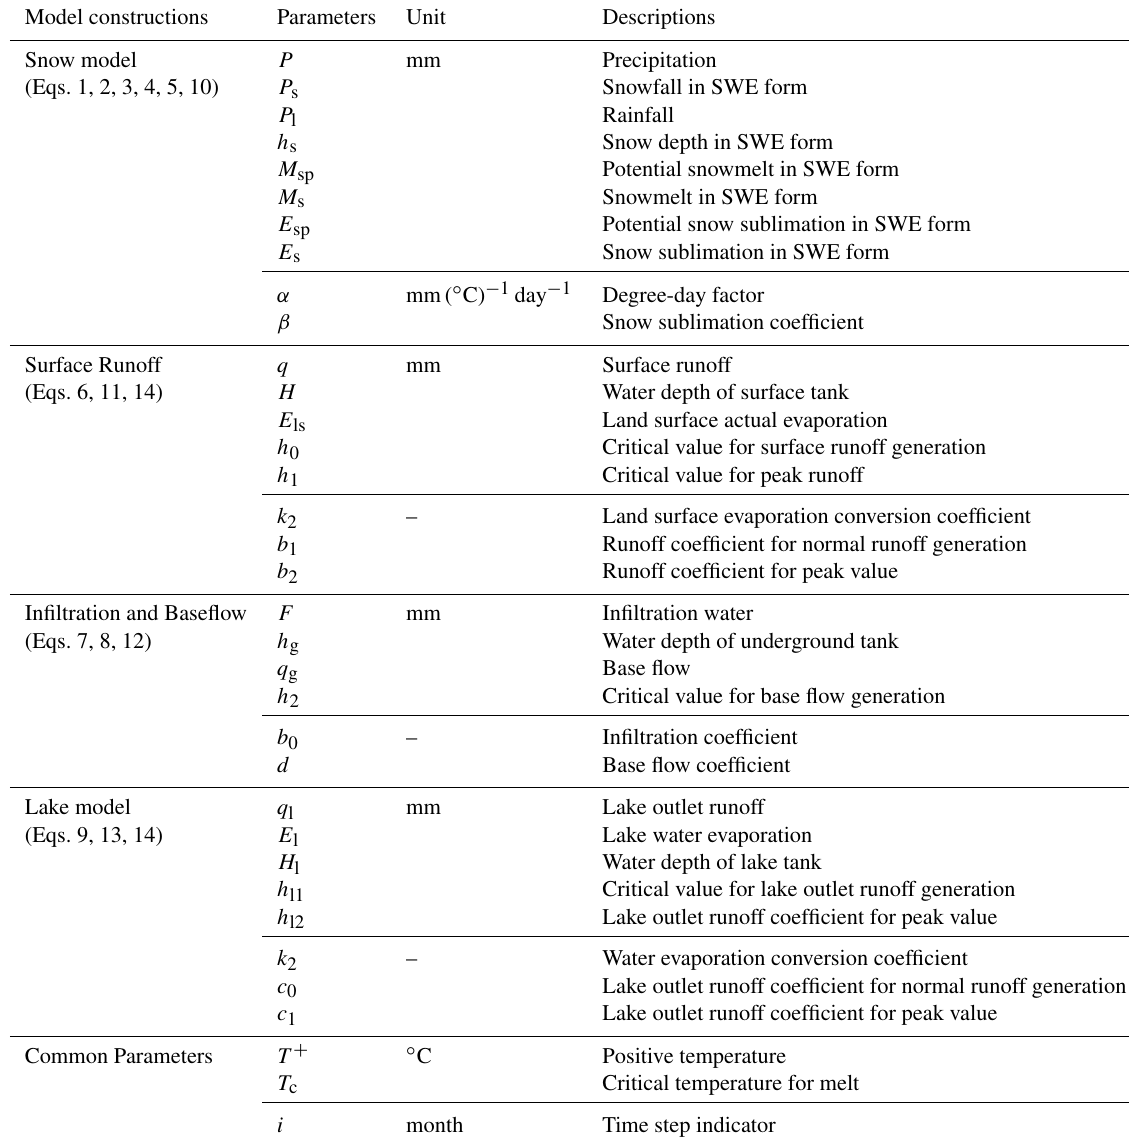
Table 2. Parameters and descriptions for the built model. Model